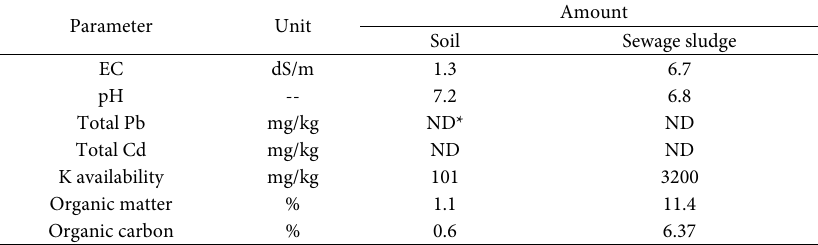
Table 1. Selected physic-chemical properties of soil and sewage sludge samples